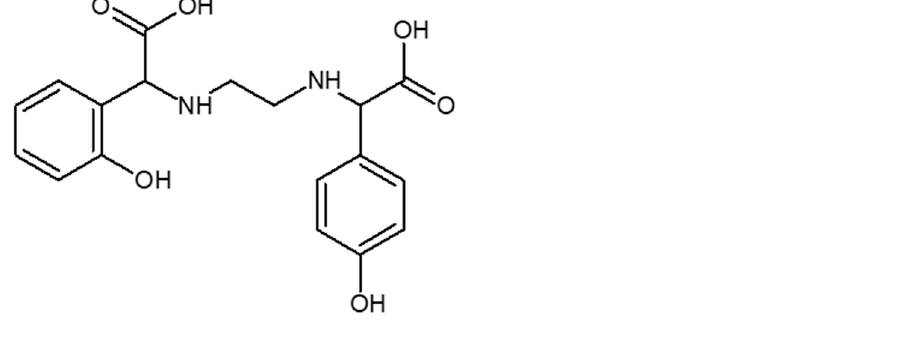
Figure 2. Structure of ethylenediamine- N -[( ortho -hydroxyphenyl) acetic acid]- N ′ -[( para - hydroxyphenyl) acetic acid ([ o , p ] EDDHA).